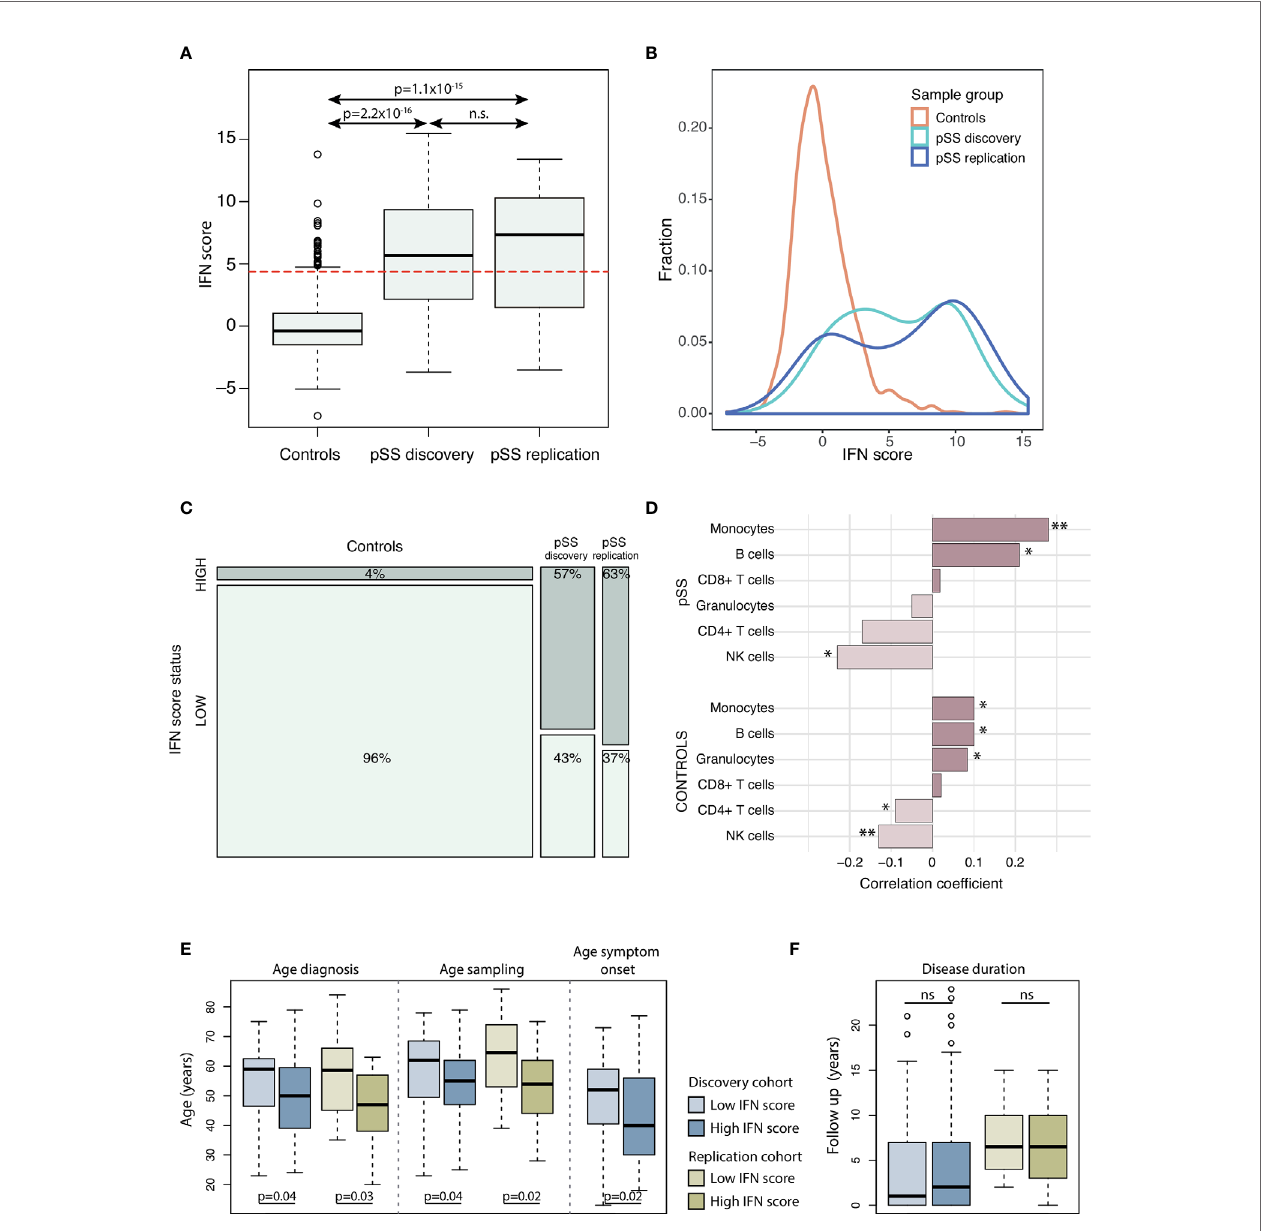
FIGURE 1 | (A) DNAm IFN scores in controls (n=587), pSS discovery cohort (n=100) and pSS replication cohort (n=48). The dotted red horizontal line indicates the threshold for high IFN score (DNAm IFN score > 4.4 corresponding to > mean IFN score ctrl +2s.d. ctrl ). (B) Density plot of IFN score distribution in controls (orange), pSS discovery cohort (light blue) and pSS replication cohort (dark blue). (C) Mosaic plot illustrating enrichment of high IFN score in the pSS discovery and pSS replication cohorts compared to controls. (D) Correlation between IFN score levels and fraction of major blood cell types in the pSS discovery cohort (upper part) and in controls (lower part). Bars with asterisks indicate signi fi cant correlations. (E, F) PSS patients in the discovery and replication cohorts strati fi ed for IFN signature status (high vs low); for (E) age (in years) at diagnosis, DNA sampling, symptom onset, and (F) disease duration from diagnosis to DNA sampling in years. (A) Kruskal-Wallis with post hoc Mann-Whitney U . (C) X 2 -test. (D) Spearman ’ s rho. (E, F) Mann-Whitney U . *P < 0.05; **P < 0.01. Boxes indicate median and interquartile range, whiskers indicate total